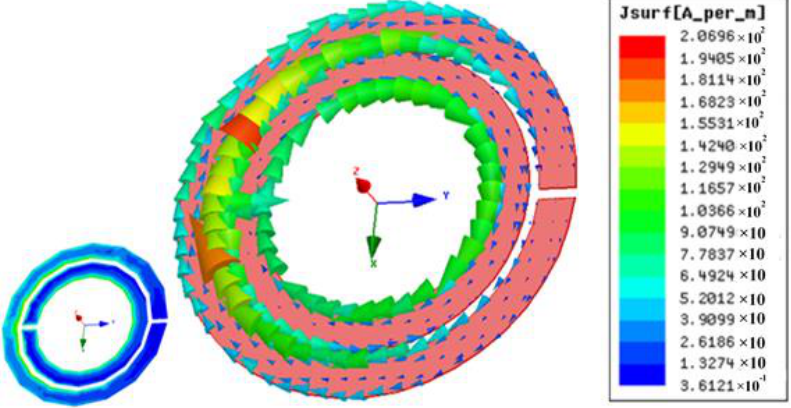
Figure 15. Surface current density and its vectors for circular SRR.